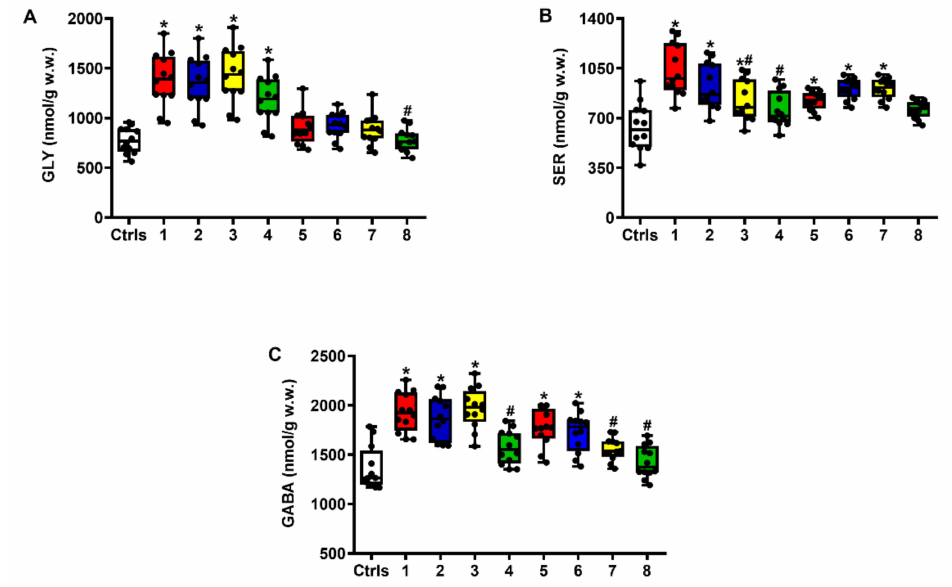
Figure 2. The box plots reporting all data points ( • ), minimum, maximum, median, 25 and 75 percentiles of Gly ( A ) and Ser ( B ) and GABA ( C ) in rats without and with the s.c. adminis- tration of increasing ILB ® doses (1, 5 and 15 mg/kg b.w.), measured at 2 and 7 days post-impact. Ctrls = control sham-operated rats; 1 = sTBI only, sacrificed at 2 days post-injury; 2 = sTBI + 1 mg/kg b.w. ILB ® , sacrificed at 2 days post-injury; 3 = sTBI + 5 mg/kg b.w. ILB ® , sacrificed at 2 days post-injury; 4 = sTBI + 15 mg/kg b.w. ILB ® , sacrificed at 2 days post-injury; 5 = sTBI only, sacrificed at 7 days post-injury; 6 = sTBI + 1 mg/kg b.w. ILB ® , sacrificed at 7 days post-injury; 7 = sTBI + 5 mg/kg b.w. ILB ® , sacrificed at 7 days post-injury; 8 = sTBI + 15 mg/kg b.w. ILB ® , sacrificed at 7 days post-injury. * Significantly different from controls, q < 0.05. # Significantly different from corresponding time of untreated sTBI rats, q <